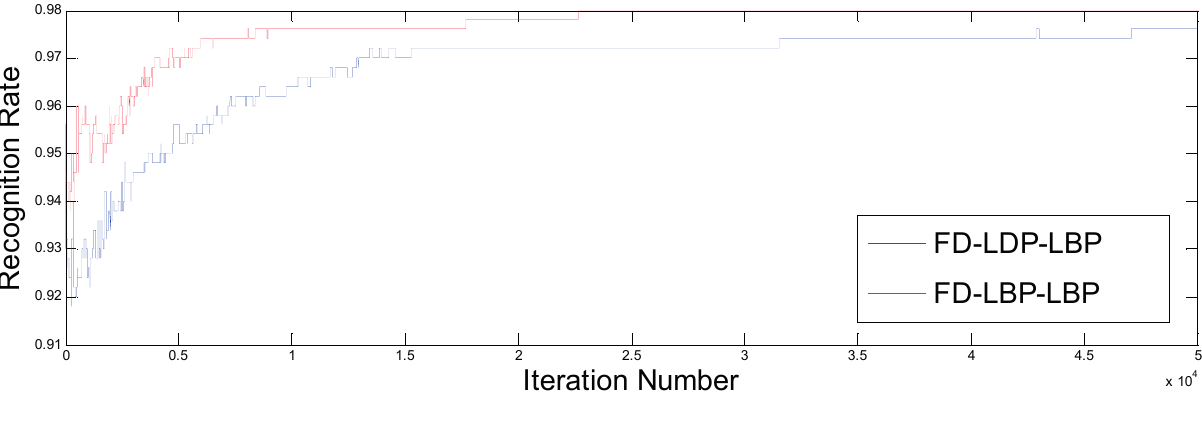
Figure 5. Fitness value evolution for the genetic algorithm. FD, fusion descriptor; LDP, local derivative pattern; LBP, local binary